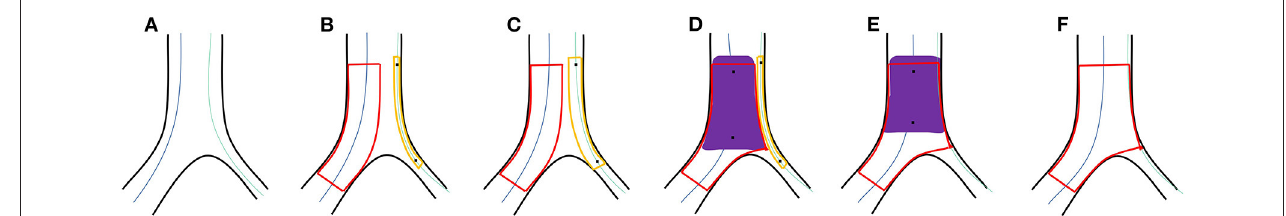
Cardiology/European Association for Cardiothoracic Surgery guidelines on myocardial revascularization were selected